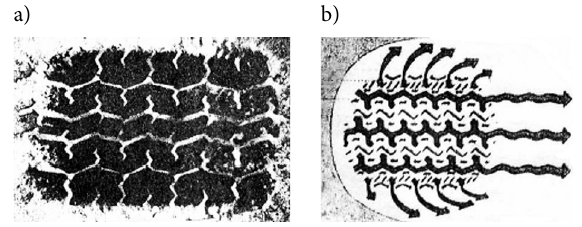
Fig. 1. View of a tire in contact with the road covered with a layer of water (a) and a scheme of water removal from the